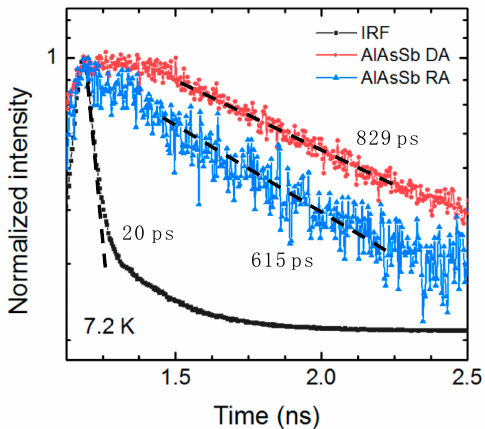
Figure 6. The TRPL data for the DA and RA samples of X band transition at 7.2 K. The IRF is also shown in the plot.